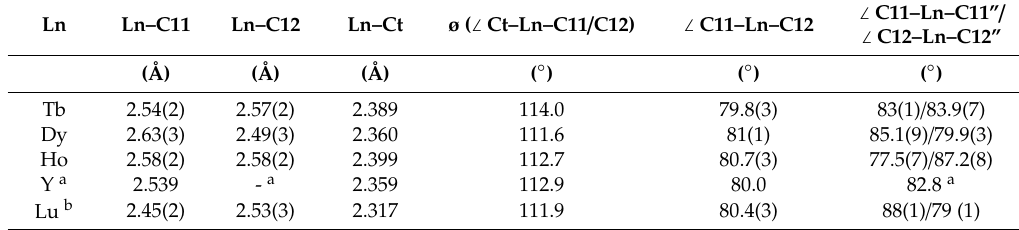
Figure 3. ORTEP view of the crystal structures of [Cp*HoMe 2 ] 3 ( 2 Ho , ( a )) and [Cp*DyMe 2 ] 3 ( 2 Dy , ( b )). Atomic displacement parameters are set at the 50% probability level. Hydrogen atoms are omitted for clarity. See Table 3 for significant bond lengths and angles. Table 3. Comparison of the crystal structures of the Cp* rare-earth metal dimethyl trimeric species 2 Ln .